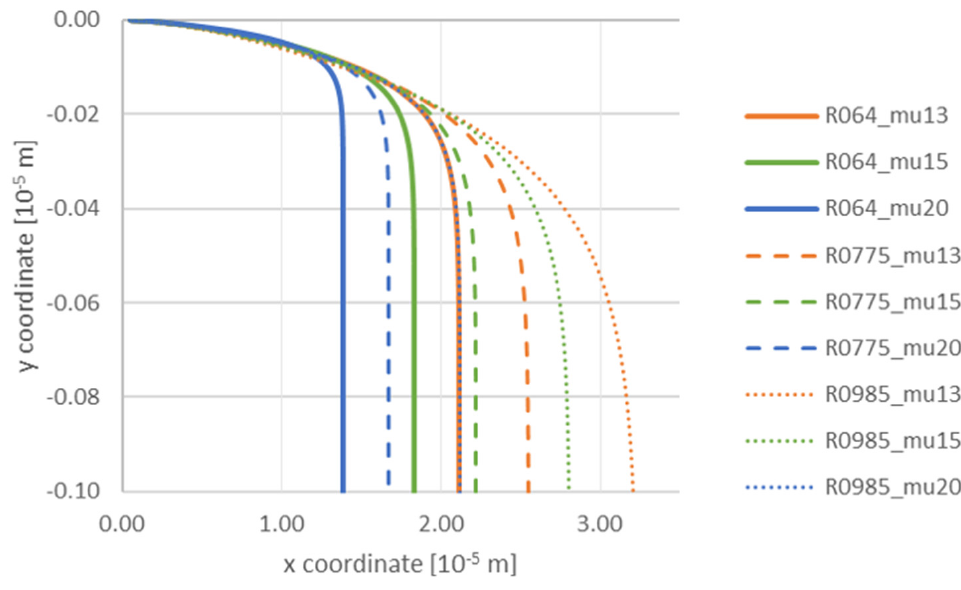
Figure 6. Analysis of influence of TiC particle size and viscosity on the trajectory with a constant gradient 0.00001 m/s. Radius of particle: R064—6.40 × 10 − 8 m; R0775—7.75 × 10 − 8 m; R0985—9.85 × 10 − 8 m. Viscosity: mu13—0.0013 Pa · s; mu15—0.0015 Pa · s; mu20—0.0020 Pa · s.